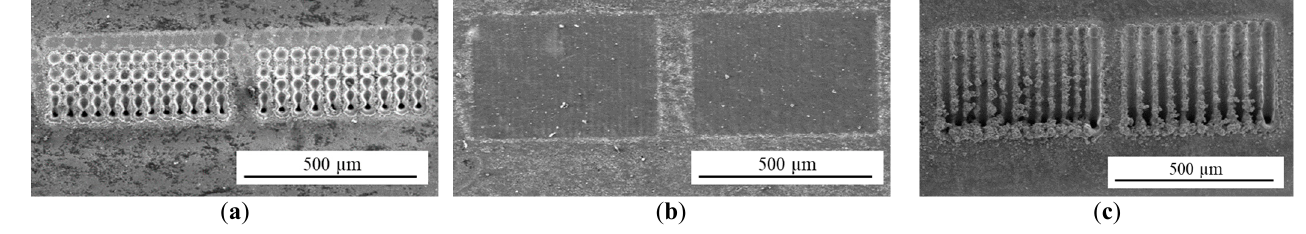
Figure 4. Examples of different phenomena that occur during texturing: ( a ) laser spot separation— discrete machined areas ( P = 16%, s = 5000 mm/s, n = 8, and l = 40 and 50 µm), ( b ) insufficient machining ( P = 1%, s = 500 mm/s, n = 1, and l = 20 and 30 µm), and ( c ) adequate machining ( P = 64%, s = 2000 mm/s, n = 8, and l = 40 and 50 µm).